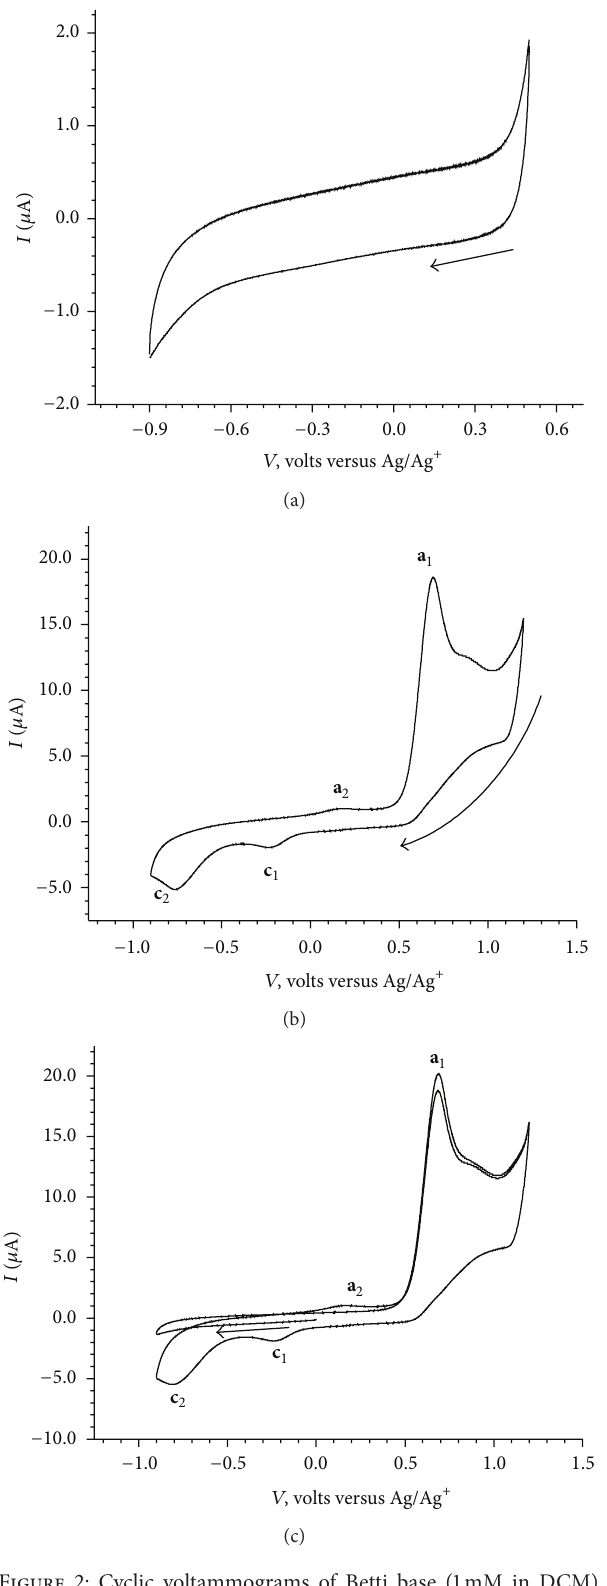
Figure 2: Cyclic voltammograms of Betti base (1mM in DCM) using 0.1M tetra-n-butylammonium hexafluorophosphate as the supporting electrolyte. (a) 0.5V to − 0.9V, (b) 1.2 V to − 0.9V, and (c) 0.0 V to − 0.9 V.